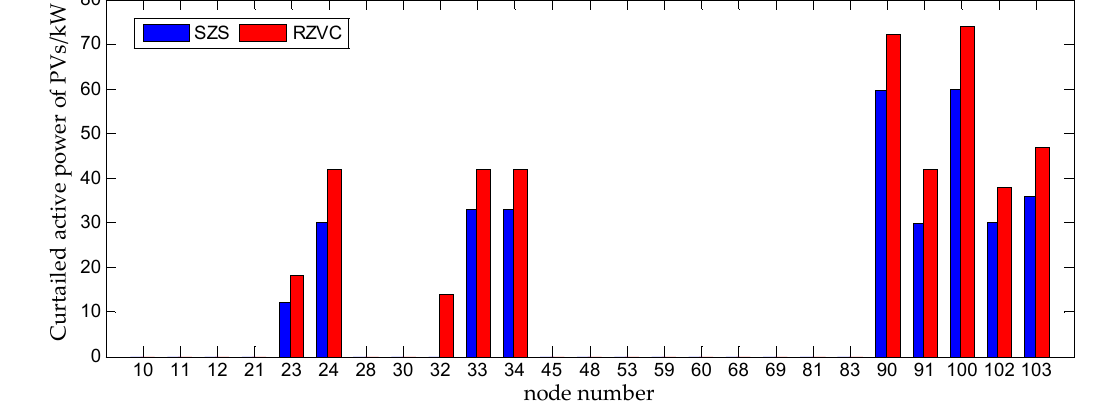
Figure 10. Curtailed active power of PV inverters under SZS and RZVC. Table 1. Comparison of the IPSO and GA.